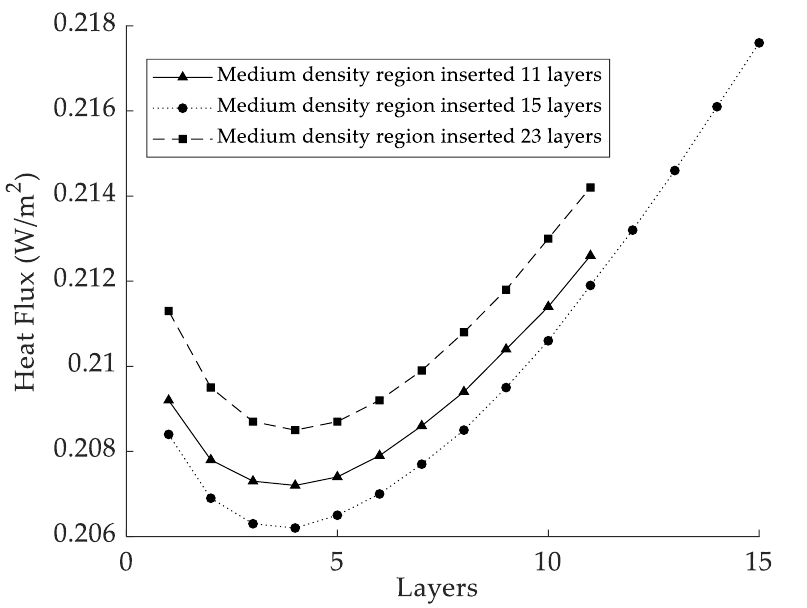
Figure 12. The heat flux varies with the number of inserted layers in the low-density region.